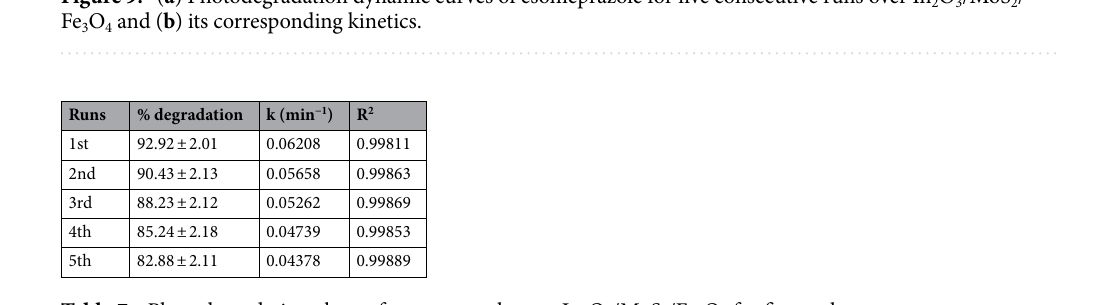
Table 7. Photodegradation chart of esomeprazole over In 2 O 3 /MoS 2 /Fe 3 O 4 for five cycles.